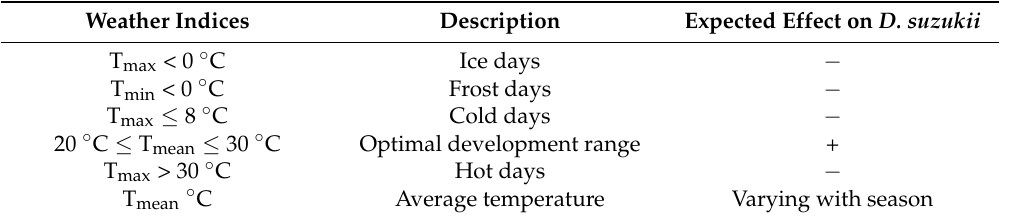
Table 3. Weather indices created to test the relationship between weather and capture rates of D. suzukii . All parameters were calculated for the 30-day period before the trap contents were collected. Expected relationships are coded ‘ − ’ as unfavorable and ‘+’ as favorable to D. suzukii .